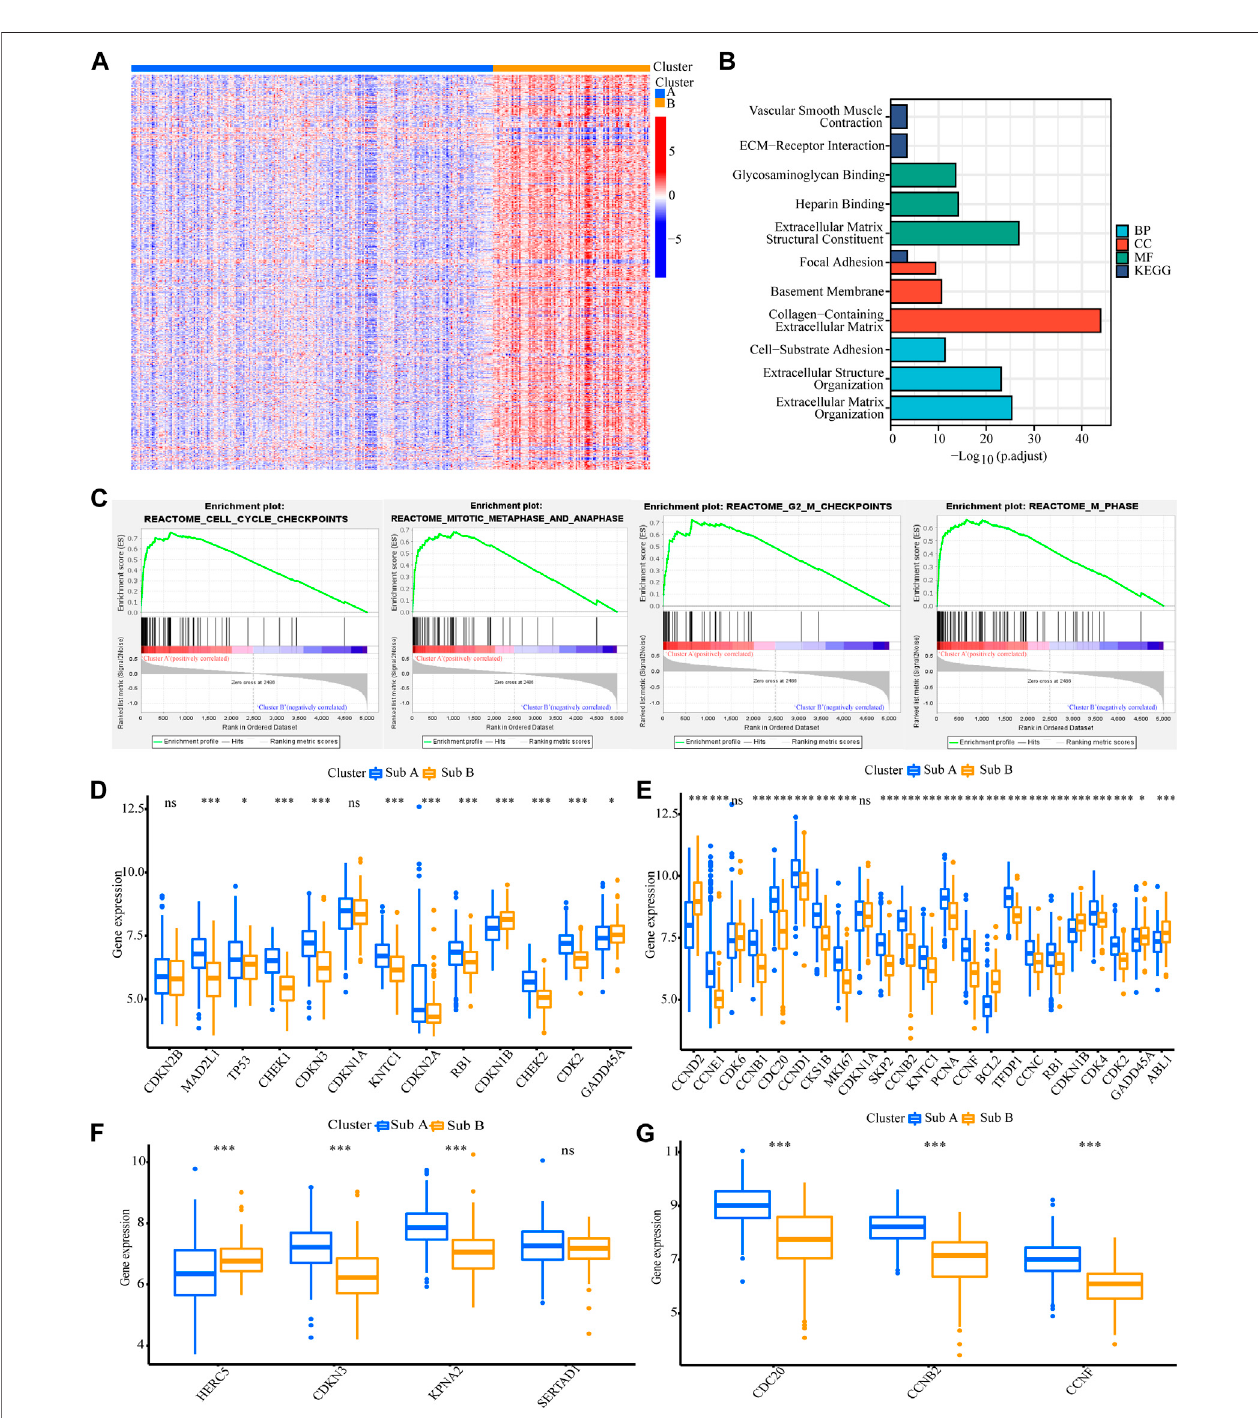
FIGURE3 | Analysesofthe biological functions of thetwo subtypes in theGEOcohort. (A) The heatmap showed the DEGbetween SubAand SubB. (B) GOand KEGG analyses on upregulated genes in Sub A vs Sub B in GEO cohort. (C) GSEA analysis of the two subtypes in the GEO cohort. (D – G) A box plot showed the difference in the expression of cell cycle checkpoint (D) , cell cycle G2/M phase transition (E) , negative regulation of nuclear division (F) and regulation of spindle checkpoint (G) between the two subtypes. * p < 0.05; ** p < 0.01; *** p < 0.001.